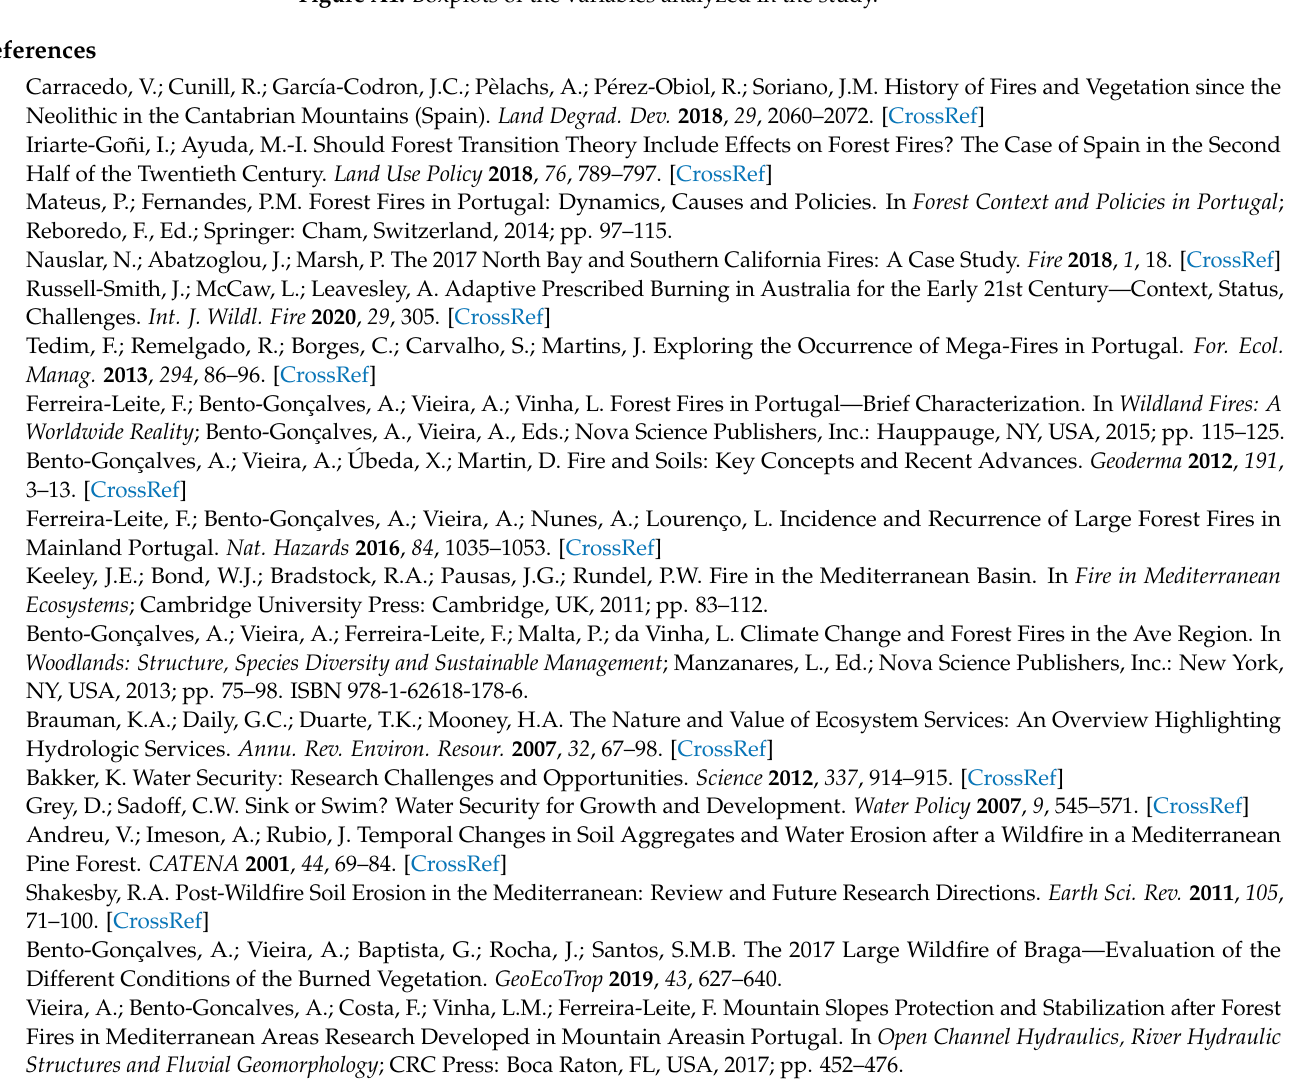
Figure A1. Boxplots of the variables analyzed in the